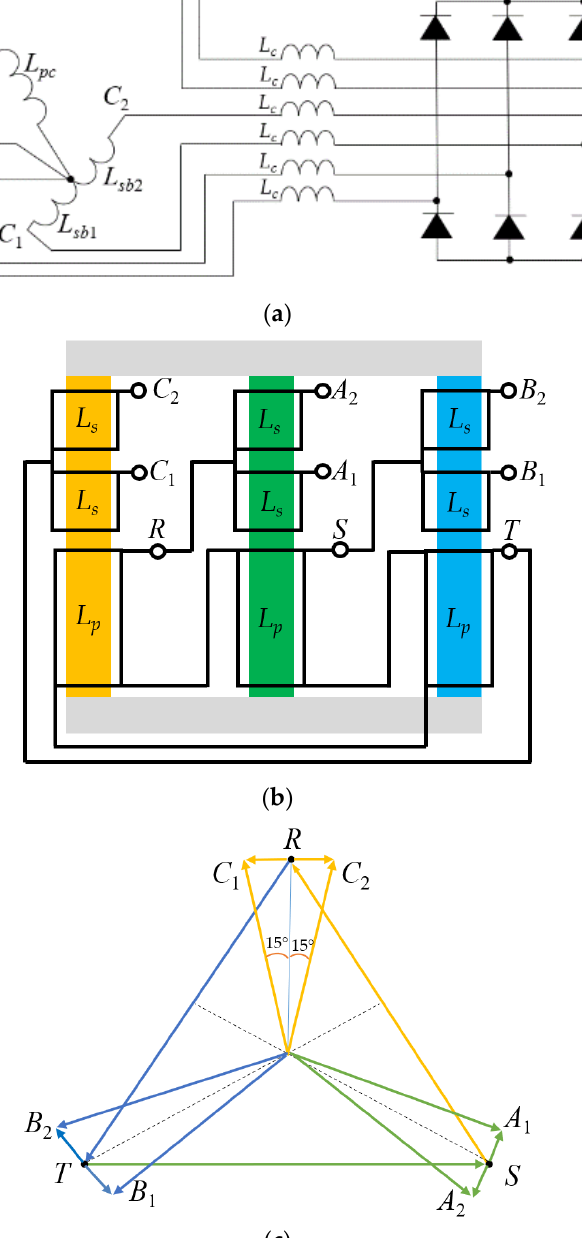
Figure 4. Schematic of an ATU. ( a ) Electrical circuit. ( b ) Structure representation. ( c ) Voltage phasor representation. The phasors of the voltages produced by the autotransformer V A 1 , V B 1 , and V C 1 were at +15 ◦ with respect to the supply voltages V R , V S , and V T , while the other set of the phasors of the voltages V A2 , V B2 , and V C2 were at − 15 ◦ with respect to supply voltages, resulting in a 12-pulse rectification [9,30,31]. The magnitudes of the secondary line voltages ( V A 1 , V B 1 , and V C 1 and ( V A2 , V B2 , and V C2 ) should be equal to each other to result in a symmetrical system and to reduce the ripple in output DC voltage